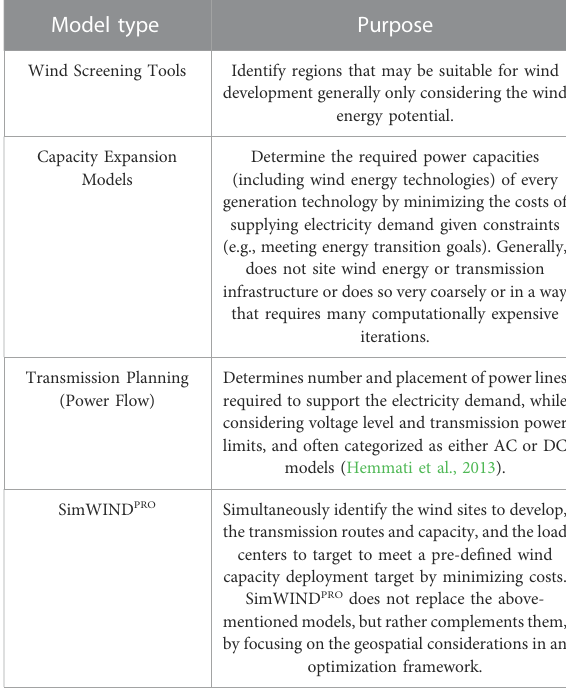
TABLE 1 Comparison of models that support wind and transmission